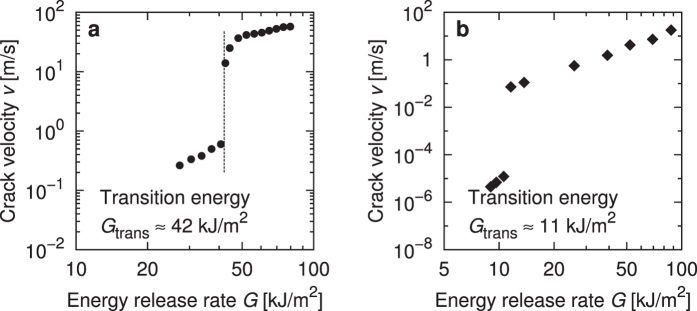
Crack velocity as a function of energy release rate obtained by (a) FEM simulation in this study and (b) experiment by ref. 6. The transition energy Gtrans indicates the energy release rate at the mode transition. Note that the figures are plotted on a different scale.